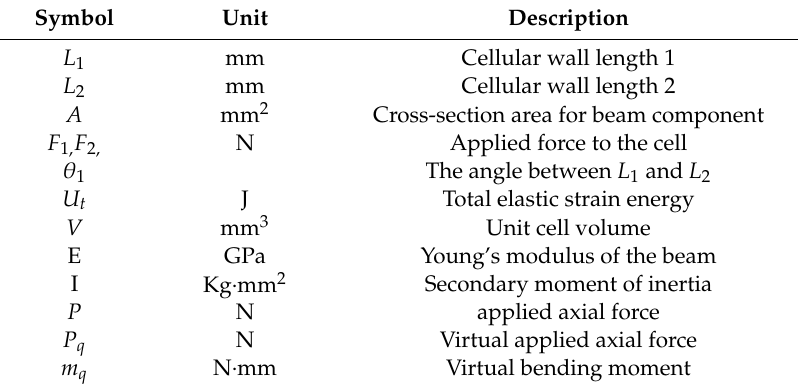
Figure 1. ( a ) the 3D re-entrant cellular structure; ( b ) Real force and moment applied to the simplified model. Table 1. Nomenclatures used in the present study.